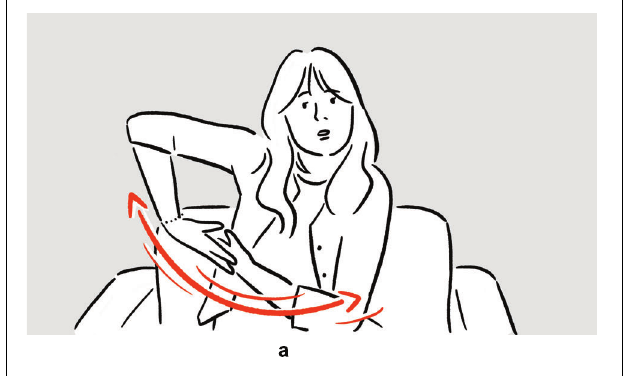
FIGURE 7 | Depiction in